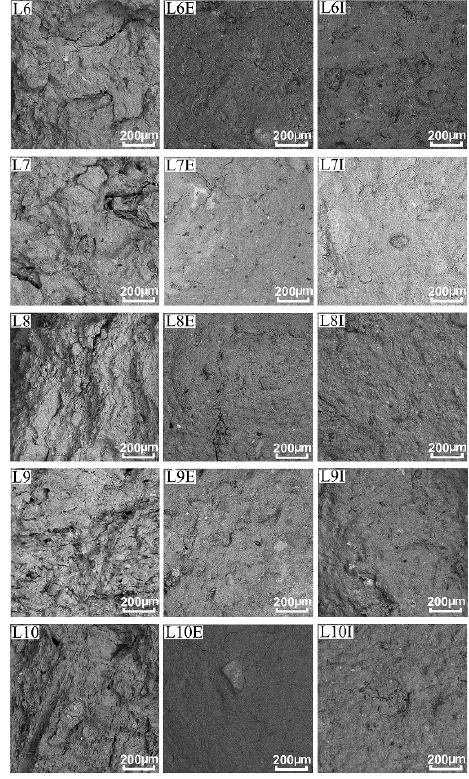
Figure 8. SEM micrographs for the Costi ș a ceramic fragments (L6–L10) from Piatra Neam ț – Lut ă rie.